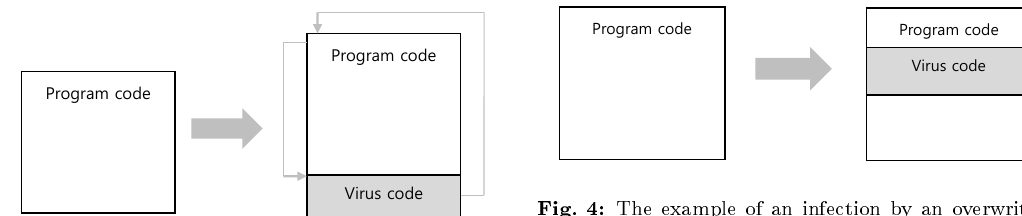
Fig. 4. The example of an infection by an overwriting Fig. 4: The example of an infection by an overwriting virus.